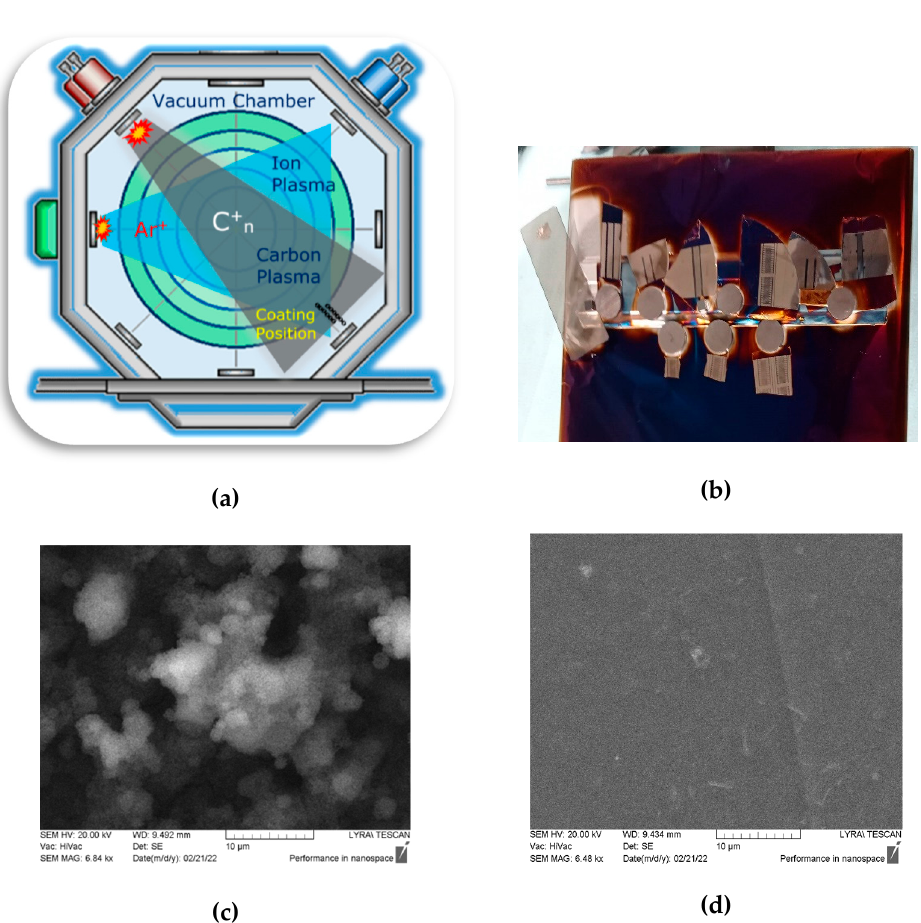
Figure 2. Deposition of carbyne-enriched nanocoatings on the SAW samples: ( a ) deposition chamber, ( b ) fixed samples during the process, ( c ) SEM image of the coating with a thickness of 280 nm, and ( d ) SEM image of the coating with a thickness of 140 nm at the same magnification of 6480 × .